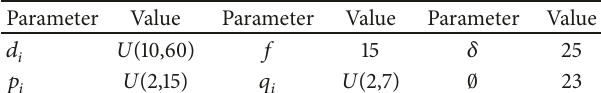
Table 2: An example of decoding results. Table 3: Parameter values of the model.